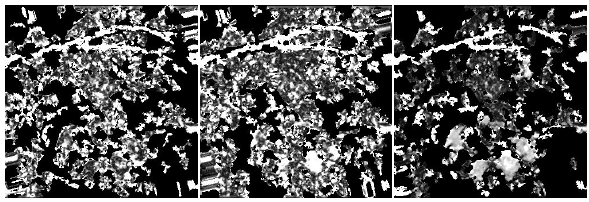
Figure 9. Resulting DEMs containg the NIR band, l.t.r. bands (2,8), (3,8) and (4,8) bad correlation of the NIR band with the blue, green or red band.